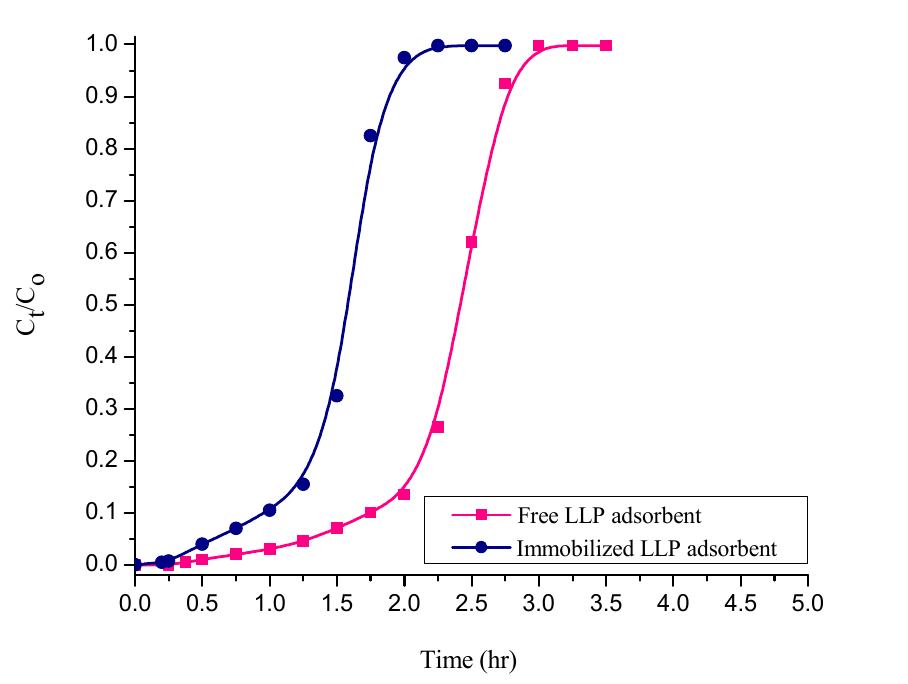
Figure 10. BTCs for adsorption of solute on free and sodium silicate-immobilized NNLP adsorbents with industrial CR dye effluent. (Initial pH: 6; bed height: 2.5 cm; flow rate: 1 mL min − 1 ; inlet adsorbate concentration: 215 mg L − 1 ; temperature: 301 K)